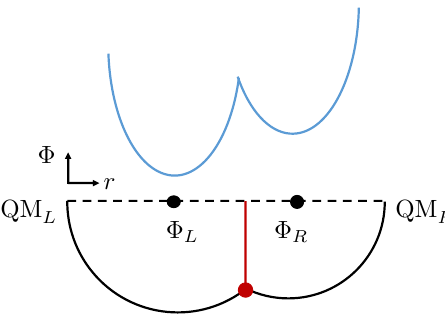
Figure 9 . Dilaton pro(cid:12)le (blue curve) at time (cid:28) = 0 as a function of the radial direction. Below we show the Euclidean evolution that creates the state with an insertion of O ‘ (red dot). The pro(cid:12)le has two local minima at the horizons (cid:8) at the left/right horizons. We show the case (cid:28) < (cid:12)= 4 L=R for which (cid:8) L < (cid:8) R , then the microscopic entanglement entropy is given by (cid:8) L